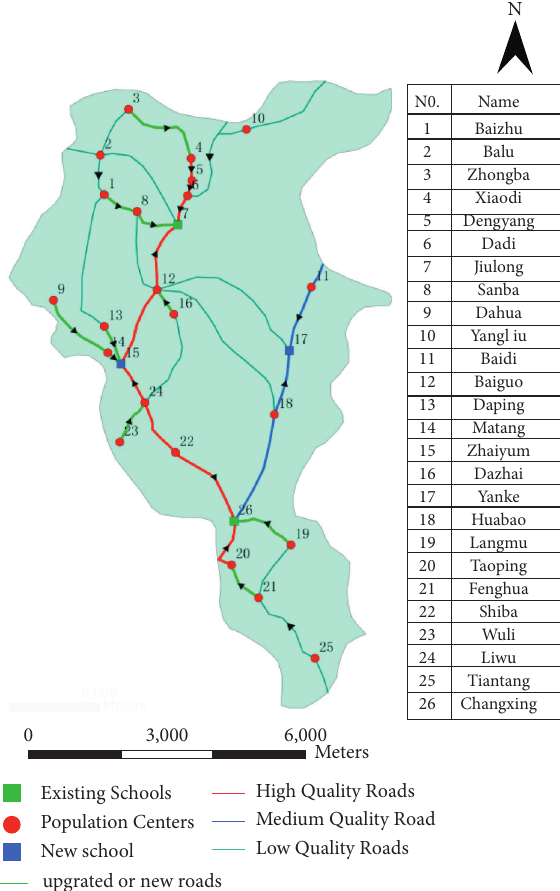
Figure 6: The optimal solution of Model 2.